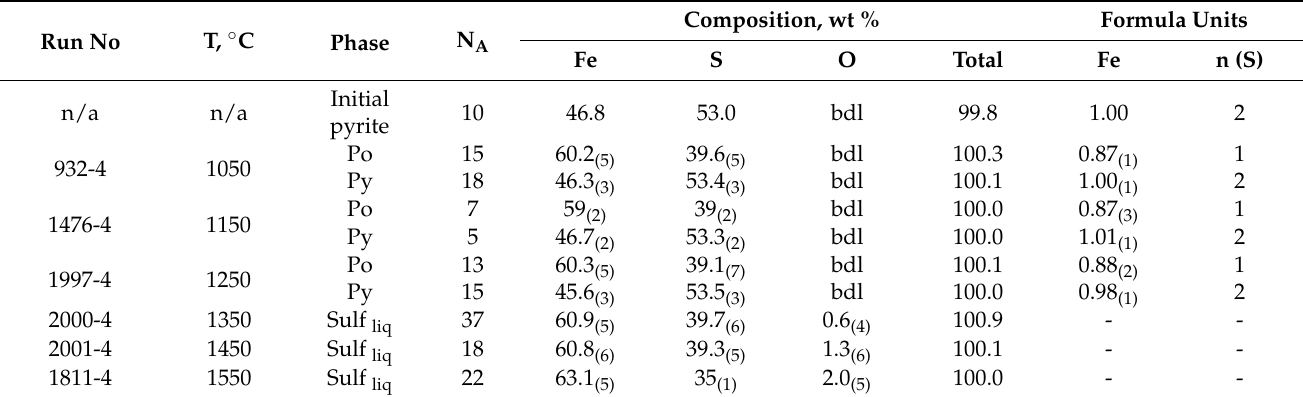
Table 3. Averaged compositions of sulfides.